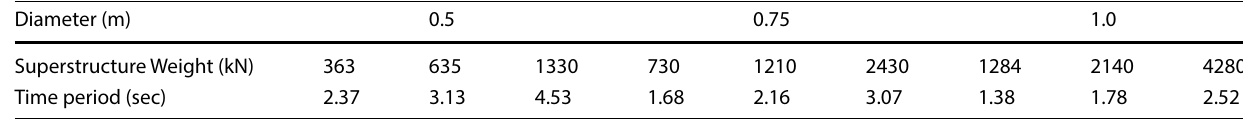
Table 10 Natural time period of soil-pile system in liquefiable condition for M-30 grade concrete pile of various configuration Diameter (m)